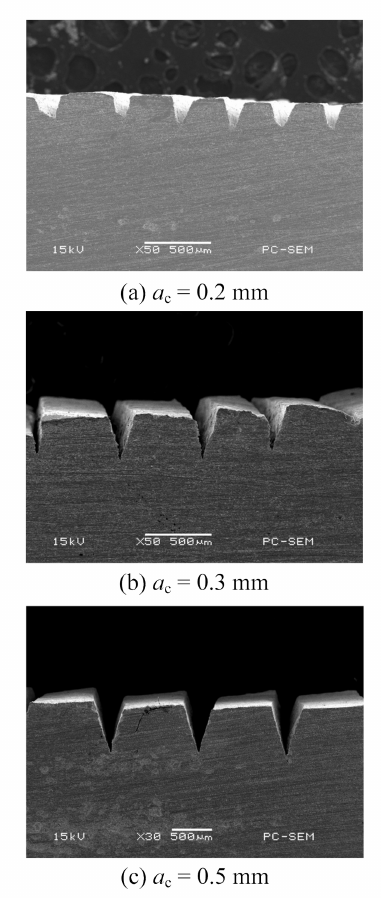
Figure 8. Morphology of microgrooves under di ff erent stamping depths from experiments.